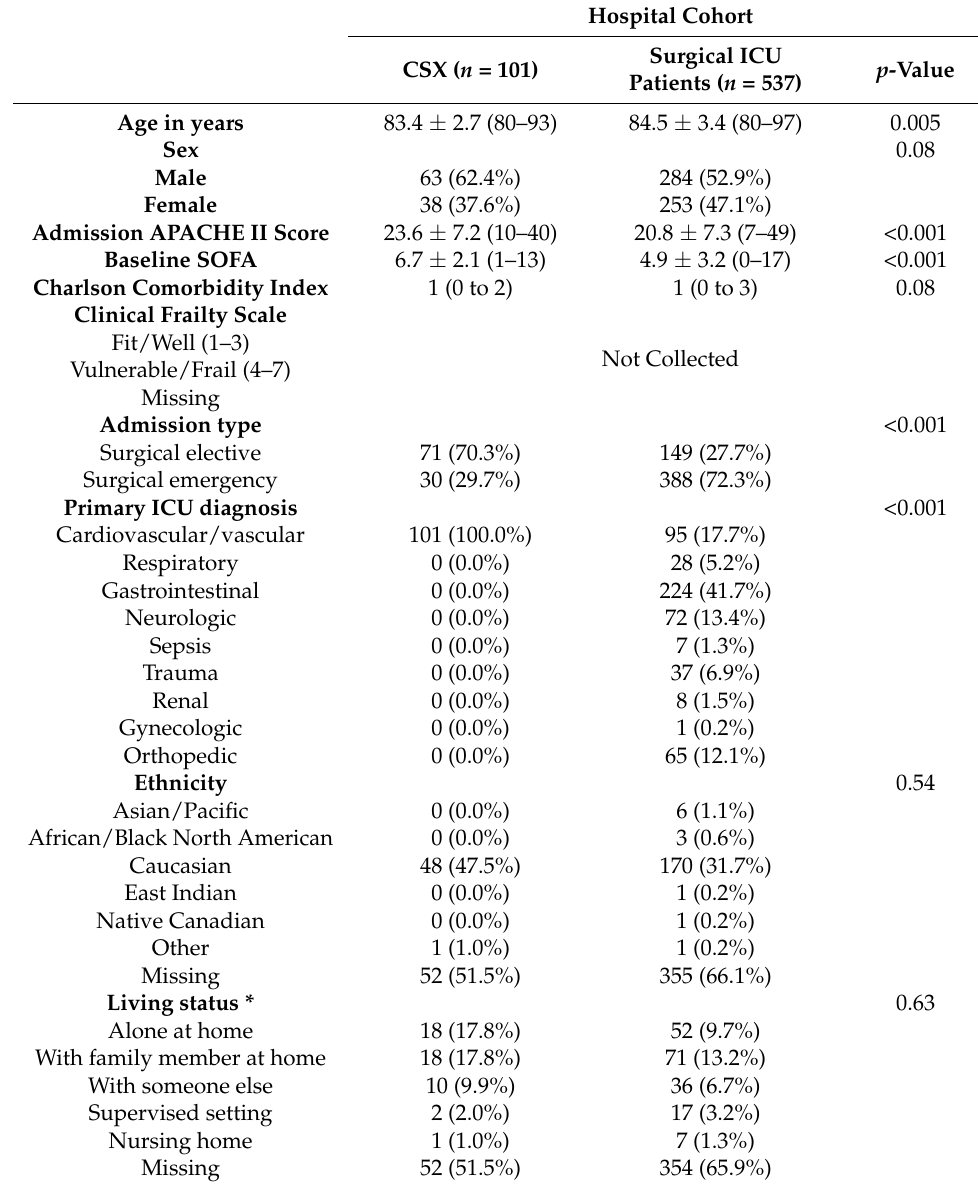
Table A1. Baseline characteristics of the hospital cohort, continuous variables are reported as mean ± standard deviation (minimum–maximum) or median (Q1 to Q3), categorical variables are reported as count (%); Abbreviations: SOFA = Sequential Organ Failure Assessment, APACHE II = Acute Physiology and Chronic Health Evaluation II. * Residential living status prior to hospital